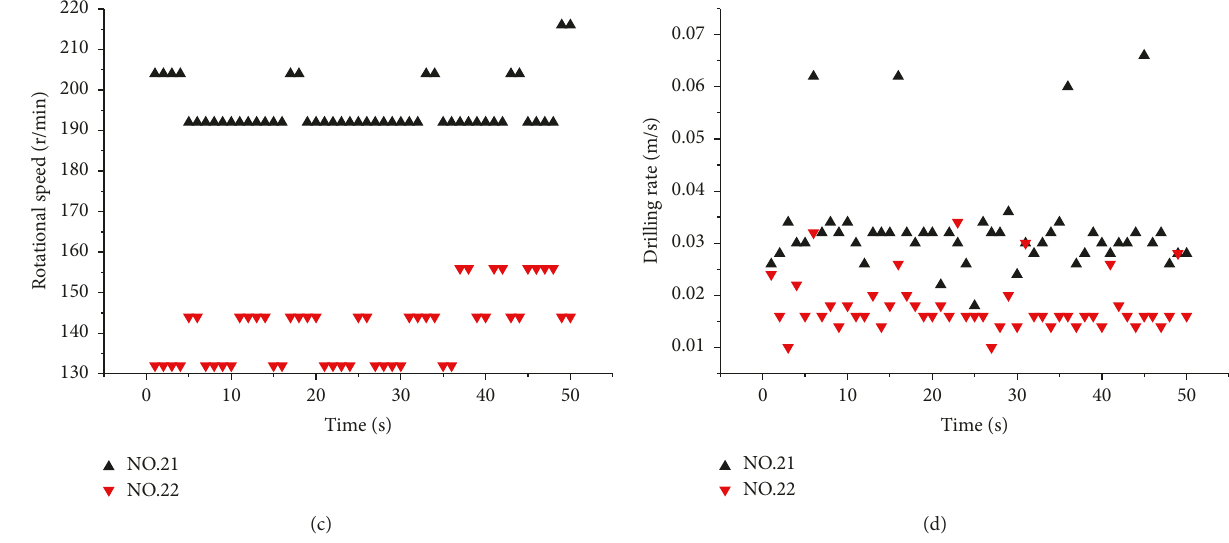
Figure 9: Variation of parameters of different boreholes in 50 seconds at the depth of 21m.